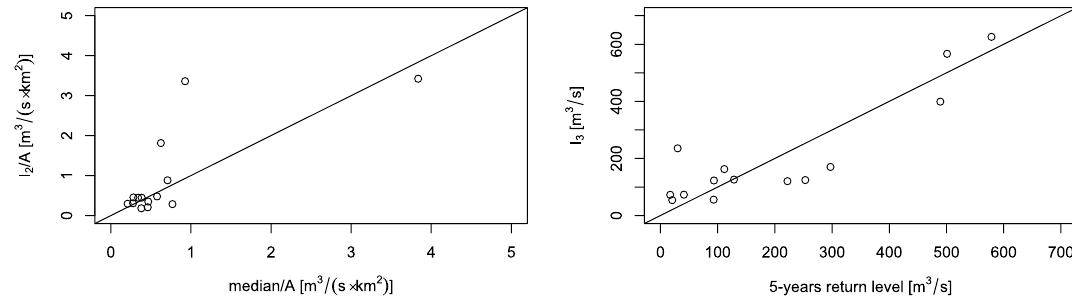
Figure 5. Empirical medians and return levels versus relative fitted indicators.